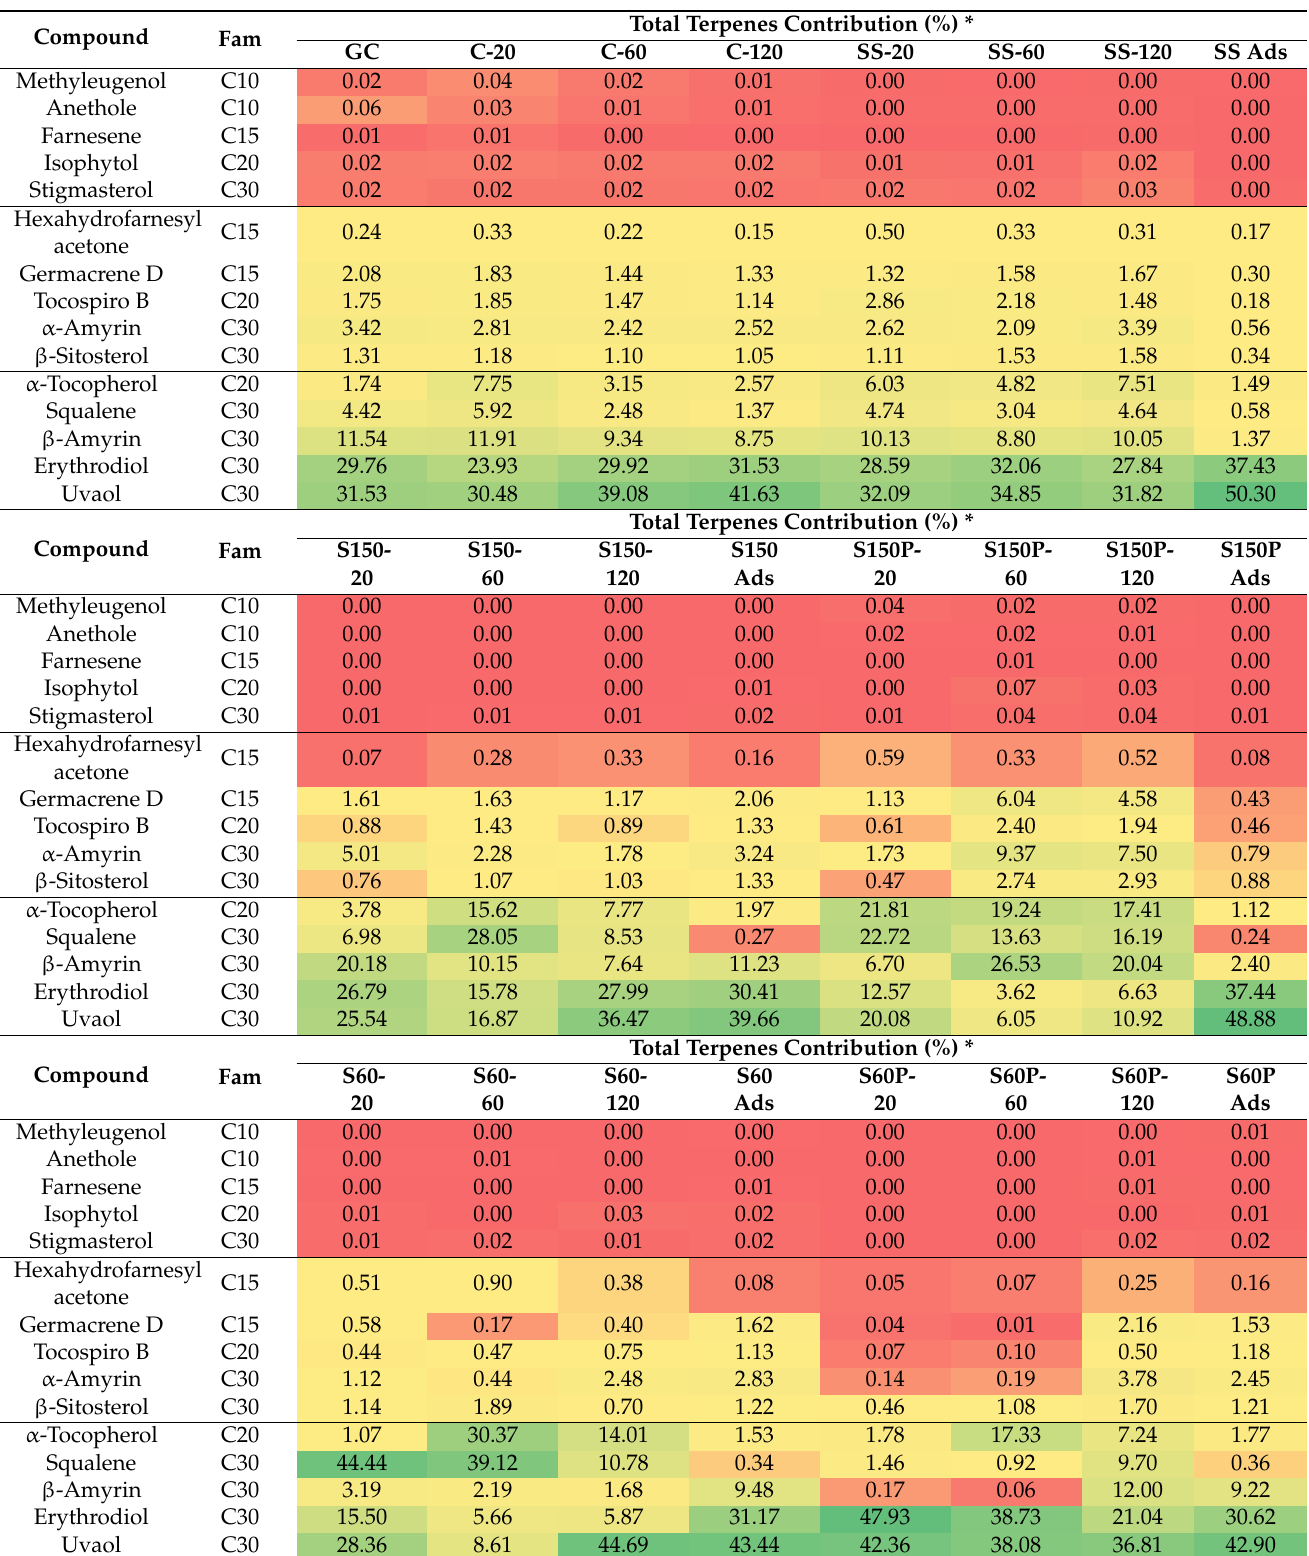
Table 2. Total terpenes contribution (%) of the main terpenes identified in this study in the 32 olive leaves extracts. Color code: Red (low concentration); Green (high